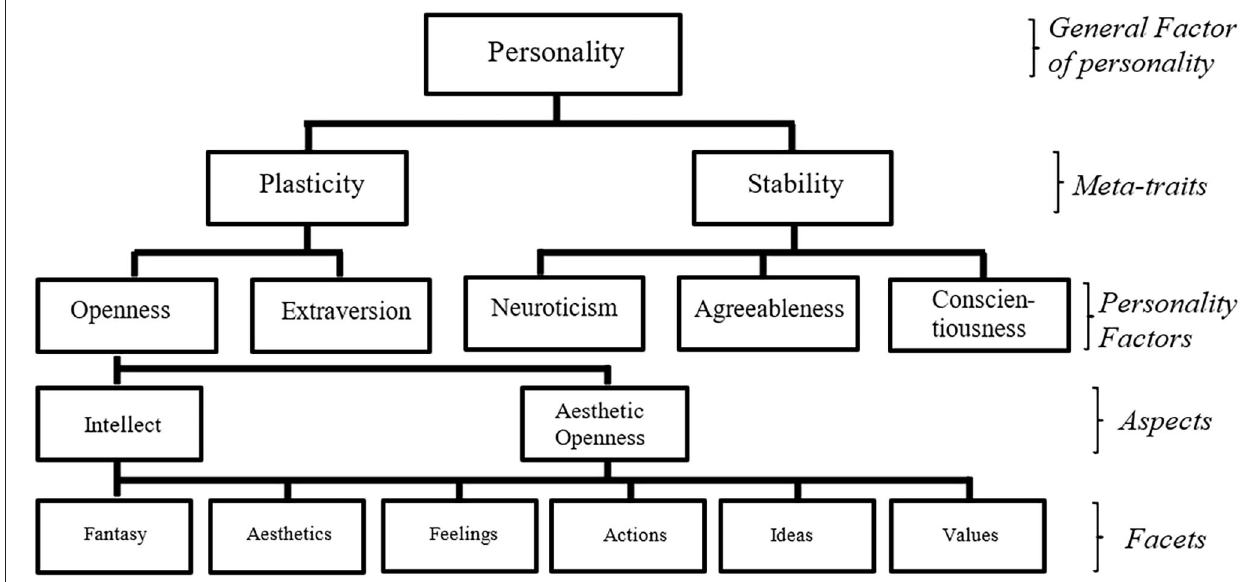
FIGURE 1 | Hierarchical model of personality (Costa and McCrae, 1992; Digman, 1997; McCrae et al., 2005; DeYoung et al., 2007; Rushton and Irwing, 2008). The descriptors referring to each of the hierarchical levels are provided on the right of this figure.